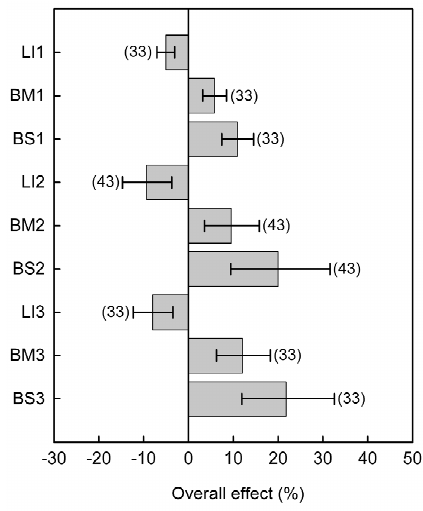
Figure 6. Effects of potted-seedling machine transplantation on lodging index at the first (LI1), second (LI2), and third (LI3) internodes, bending moment at the first (BM1), second (BM2), and third (BM3) internodes, and breaking strength at the first (BS1), second (BS2), and third (BS3) internodes in rice paddies. The numbers near the error bars denote the number of observations for each variable. Error bars represent 95% confidence intervals.